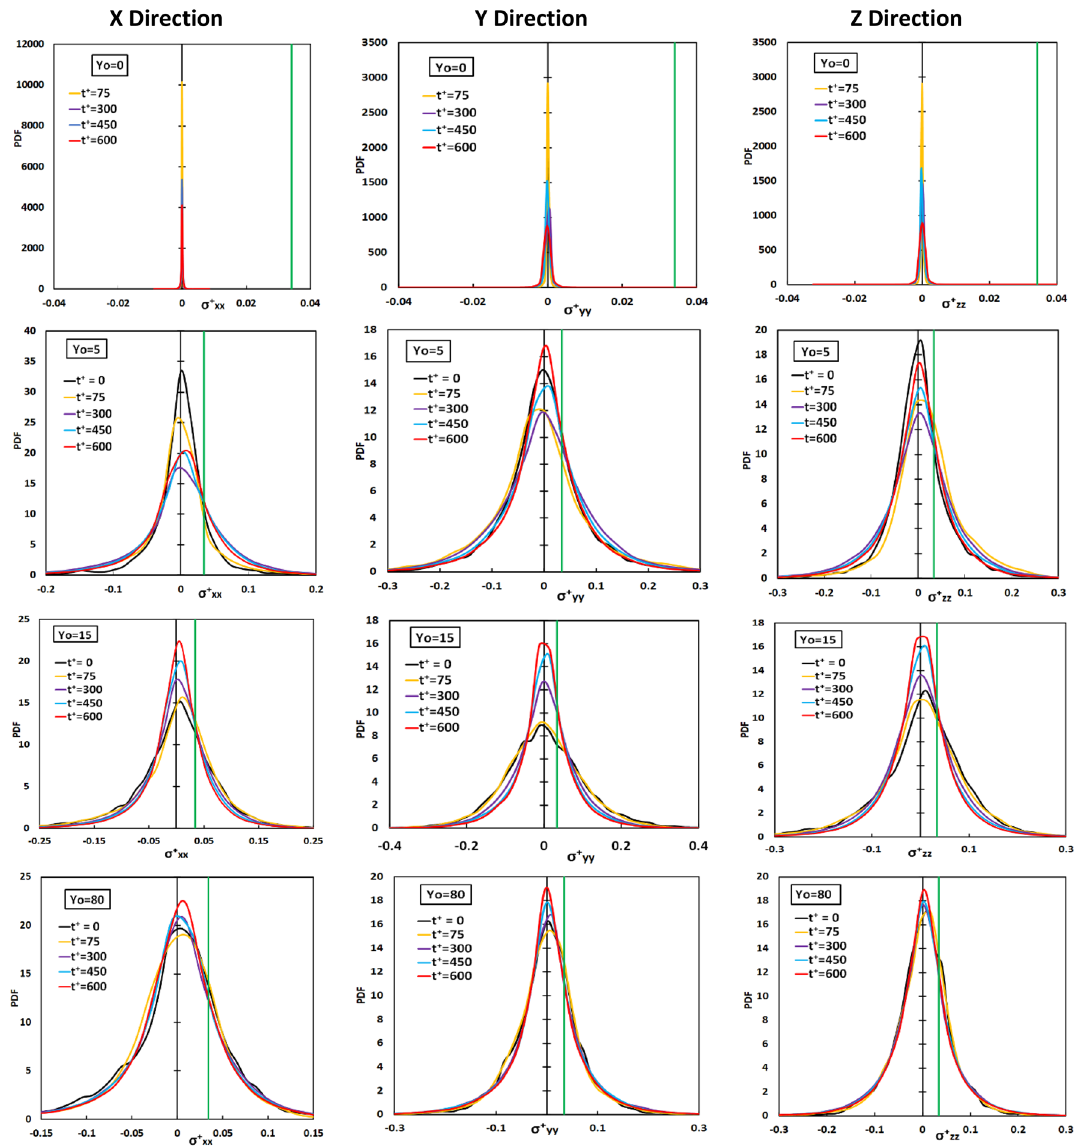
Figure 3. Probability density function for the extensional stress components in x, y, z directions of particles released at Y 0 = 0, 5, 15, 80 at different time instances Poiseuille–Couette flow field. The green line represents the critical stress of 1.2 Pa for the case modeled the same trend in all directions. The average stress for vWF particles released at the center of the channel remained roughly constant, as expected based on the Eulerian stress profile and as discussed for the PC flow case. Particles released at the wall or very close to it (at Y 0 = 0 and 1.5) did not have a chance to disperse away from the wall and experience high stresses. As the time after particle release increased, the particles dispersed more uniformly across the channel and the average stress was expected to reach the bulk average Eulerian value across the channel. After injecting particles, the full distribution of extensional stress was calculated at specific time instances and is presented in Fig. 7. It appears that for all three directions x , y , z the extensional stress distribution for par- ticles released within the viscous sublayer and the buffer region changed the most with time. The most dramatic change was from t + = 15 to t + = 75. The variance of the PDF for the stress distribution increased as time elapsed, as indicated by the widening of the PDFs. When particles were released in the log-layer (Y 0 = 75) and at the center of the channel the changes were moderate. Figure 8 is a presentation of the PDF of the distribution of the history of the stress on particles at two time instances after being released in the flow field. The PDFs shown are for particles released at Y 0 = 1.5, 5, 15, 75, 300. It is clear that the integrated stress on particles at t + = 150 shows a narrow distribution, roughly in the range from 0 to 10 for Y 0 = 1.5 and 300 and from 0 to 25 for Y 0 = 5, 15, 75. This observation can be interpreted when one considers the Eulerian stress profile depicted in Fig. 5 and the high Sc for the vWF particles. For particle